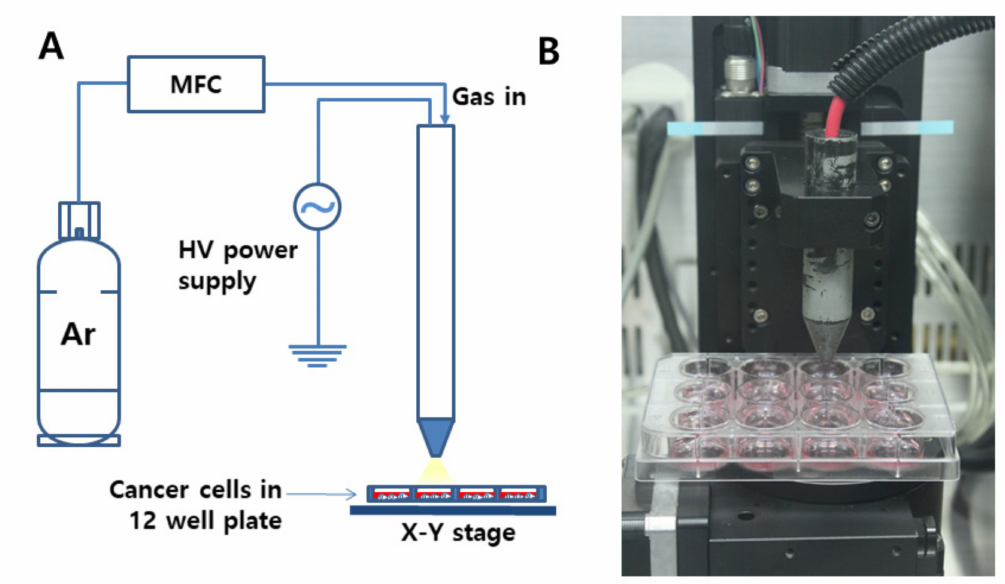
Figure 1. ( A ) Schematic diagram of cold atmospheric plasma (CAP) equipment for the treatment of cells. ( B ) Photograph of the CAP nozzle. Flow rate of Ar gas was 5 L / min. Discharge power was adjusted at 45 W, at 8.5 kV, and 20 kHz radio frequency at atmospheric condition. The distance was 3 cm from the nozzle to the cells in a 12-well